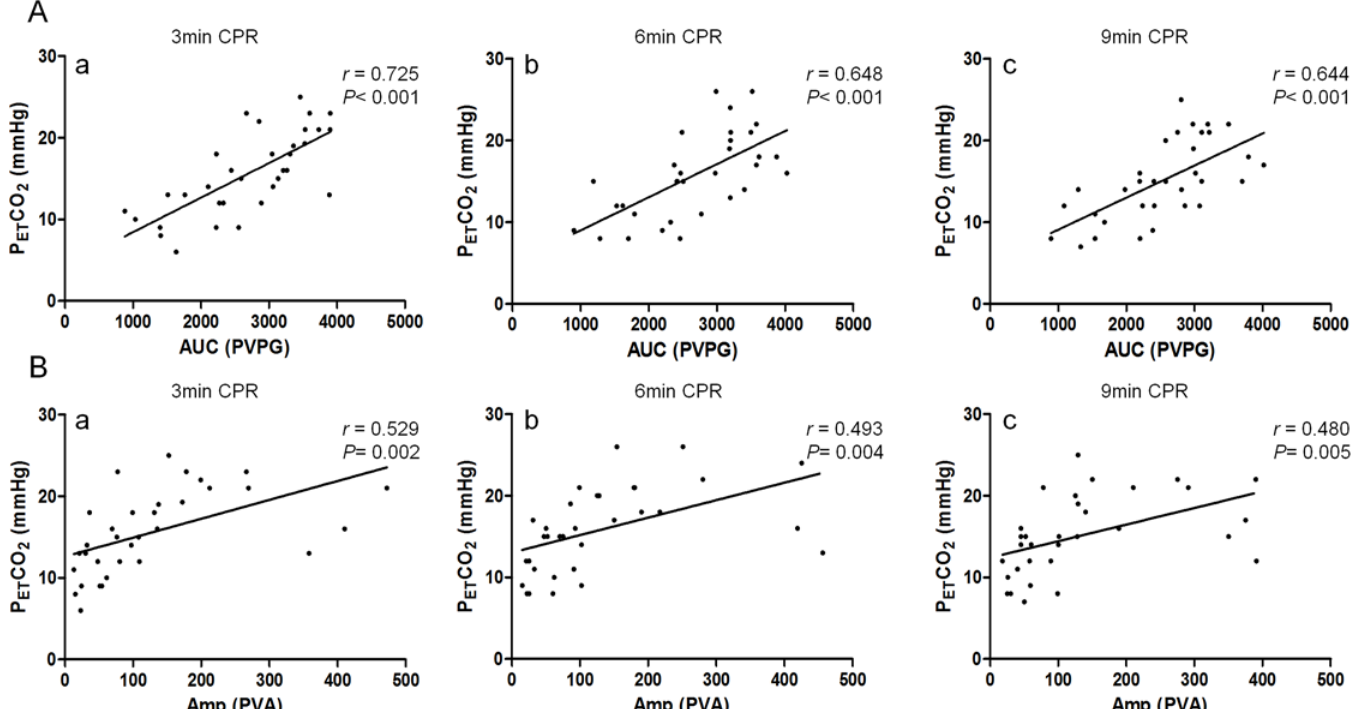
Fig 4. A.The correlation between AUC and P ET CO 2 during different stages of CPR a. AUC was positively correlated with P ET CO 2 at the 3 rd minute of CPR ( r = 0.725, P < 0.001). b. At the 6 th minute of CPR, AUC was positively correlated with P ET CO 2 ( r = 0.648, P < 0.001). c. AUC was positively correlated with P ET CO 2 at the 9 th minute of CPR ( r = 0.644, P < 0.001). B. The correlation between Amp and P ET CO 2 during different stages of CPR a. Amp was positively correlated with P ET CO 2 at the 3 rd minute of CPR ( r = 0.529, P = 0.002). b. At the 6 th minute of CPR, Amp was positively correlated with P ET CO 2 ( r = 0.493, P = 0.004). c. At the 9 th minute of CPR, Amp was positively correlated with P ET CO 2 ( r = 0.480, P =